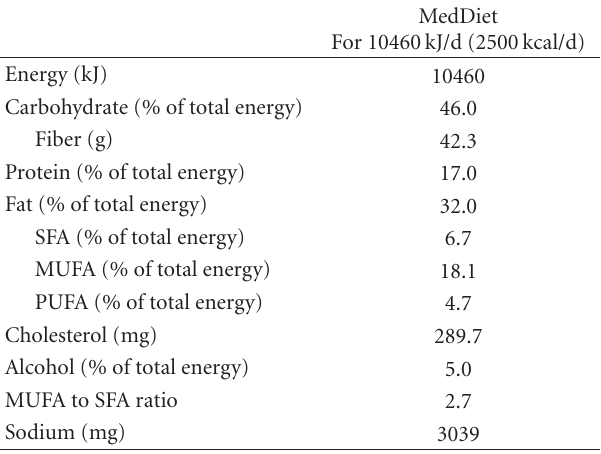
Table 2: Daily nutritional composition of the Mediterranean diet intervention for a 10460 kJ/d (2500kcal/d)